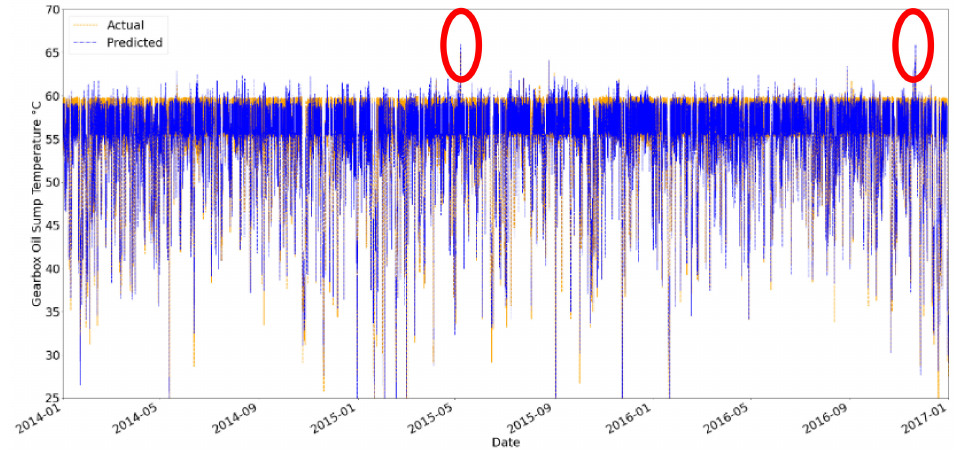
Figure 19. Predicted and Actual Gearbox Oil Sump Temperatures in R80790 WT vs. Date [January 2016 to January 2017].